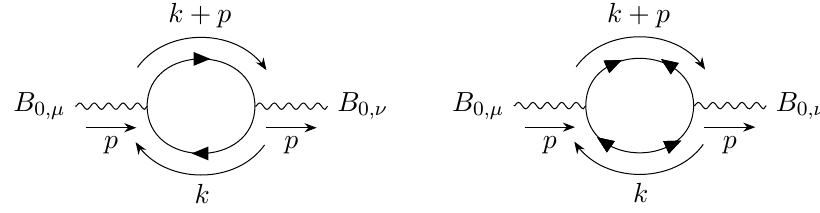
Figure 9. The Cartan fermion contributions to the B ∧ dB